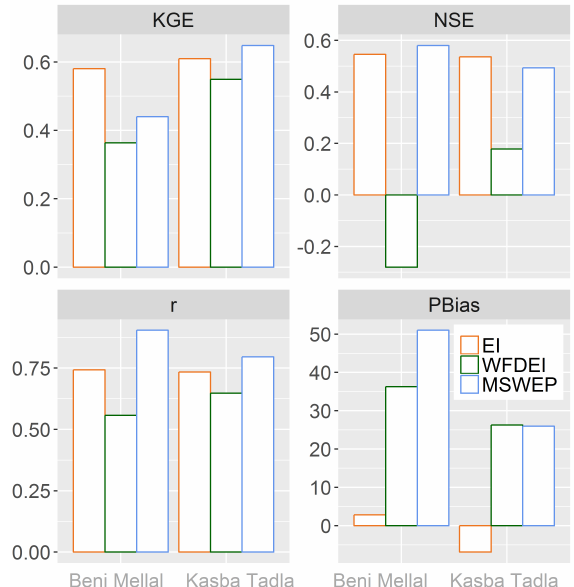
Figure 4. Performance metrics of daily EI, WFDEI and MSWEP precipitation products at Beni Mellal and Kasba Tadla weather sta- tions, including KGE, NSE, r and